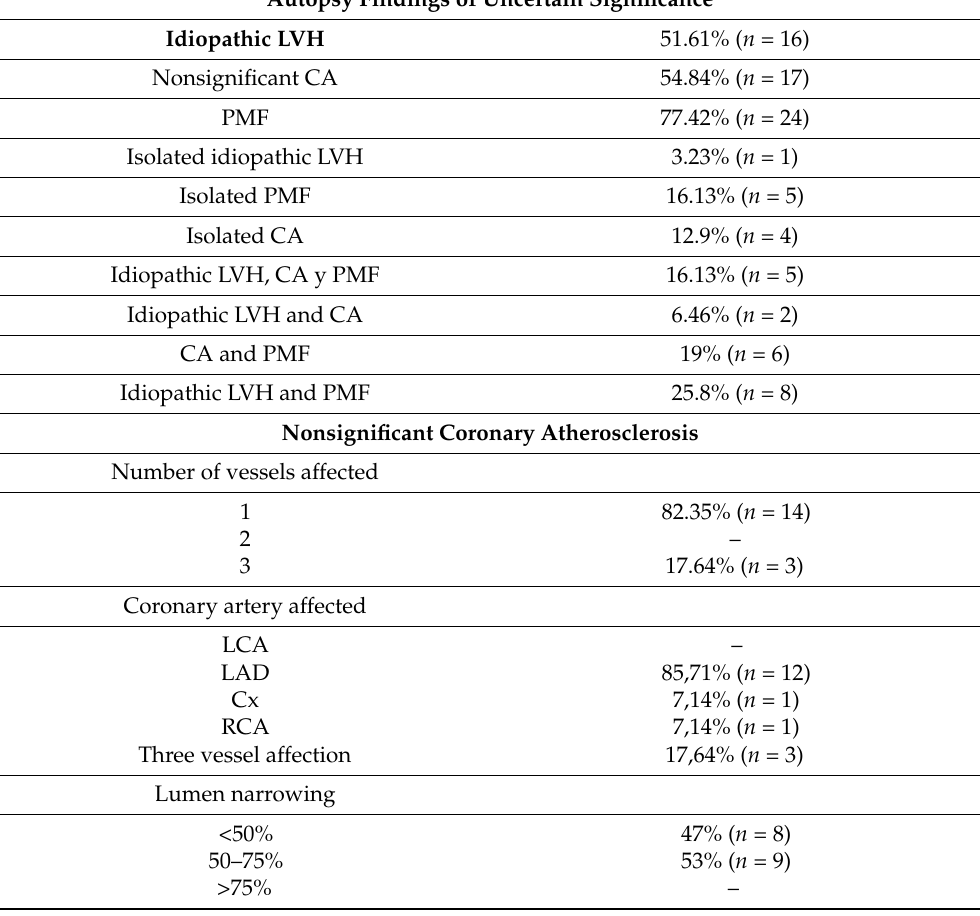
Table 2. Description of autopsy findings of uncertain significance. LVH, left ventricular hypertrophy; CA, coronary arteriosclerosis; PMF, primary myocardial fibrosis; LCA, left coronary artery; LAD, left anterior descending artery; Cx, circumflex artery; RCA, right coronary